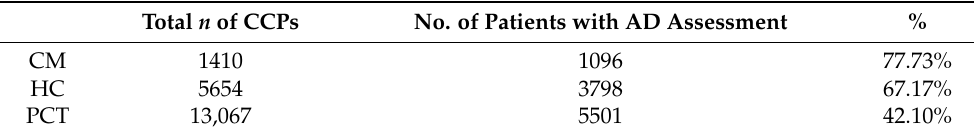
Table 4. Distribution of adherence assessment in CCPs according to care unit. Total n of